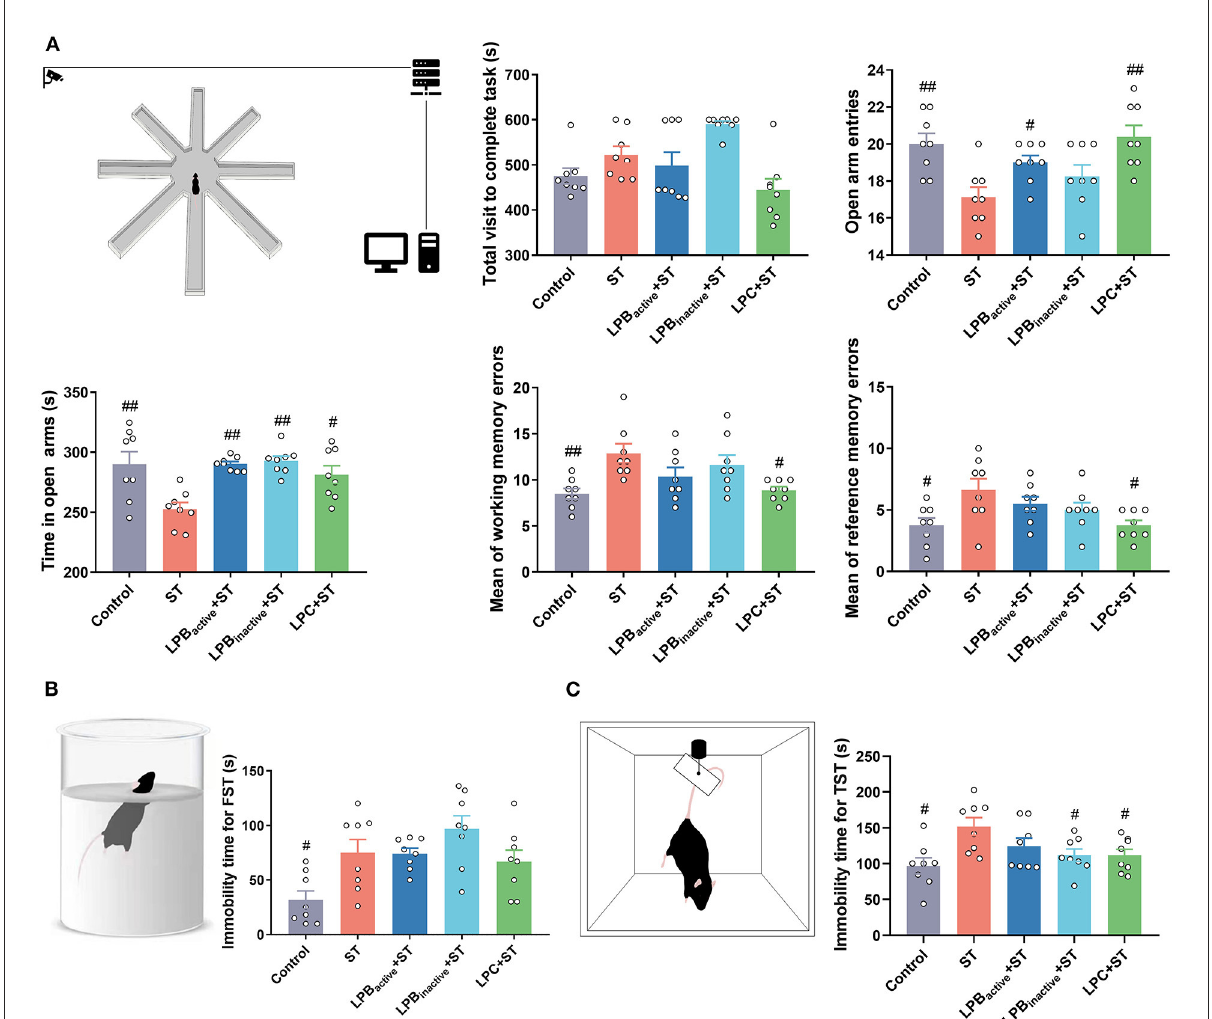
FIGURE7 Radial arm maze (RAM), forced swim test (FST), and tail suspension test (TST) representing cognitive impairment and depressive-like behaviors. (A) RAM data. A cartoon of the apparatus for RAM is shown. Statistical analysis of the total visit to complete task, open arm entries, time in open arms, and mean of working and reference memory errors. (B) FST data. A cartoon of the apparatus for FST and the analysis of immobility time. (C) TST data. A cartoon of the apparatus for TST and the analysis of immobility time. The data shown as mean ± SEM were analyzed by one-way ANOVA and Tukey’s test ( N = 8 in each group). # Indicates the significance compared to ST group. # p < 0.05, ## p < 0.01.